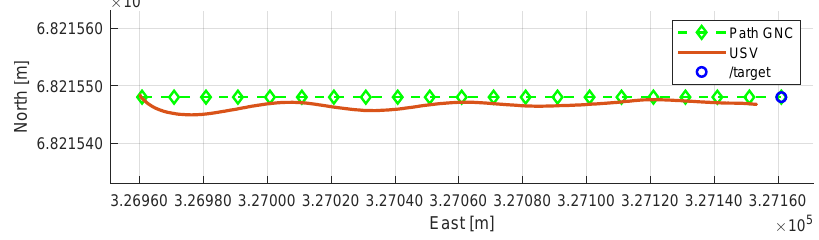
Figure 17. USV Control scenario: USV trajectory for the path-following algorithm, where the last waypoint is equal to the ROS topic / target